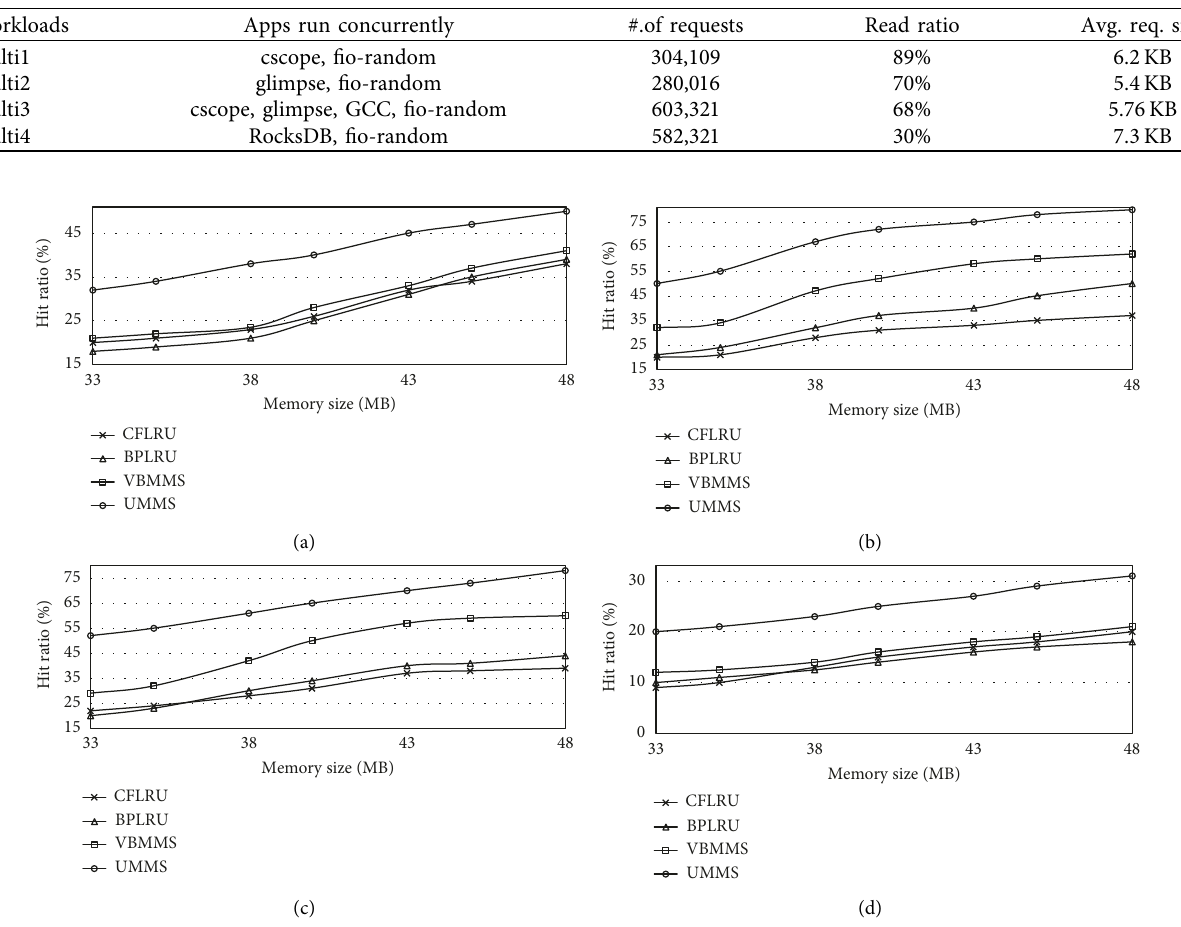
Figure 6: Buffer hit ratio comparison. (a) Multi1 workload. (b) Multi2 workload. (c) Multi3 workload. (d) Multi4